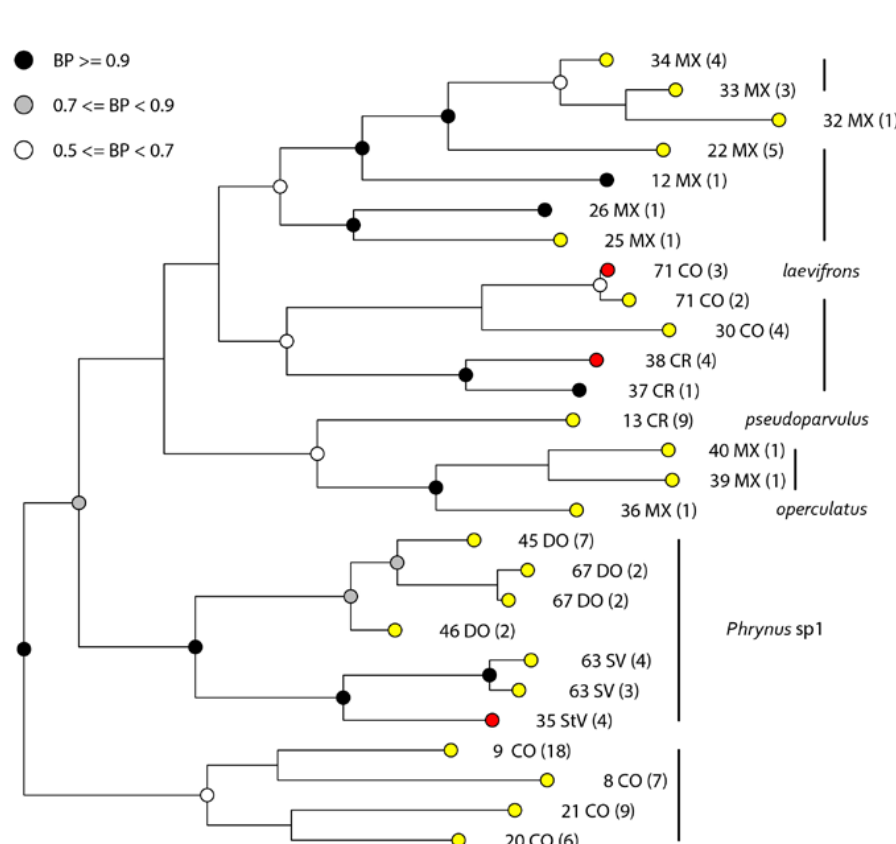
Figure 4. Details of clade C from Figure 3. Colored circles indicate the habitat of each sampled species; yellow = epigean, black = cave, and red = both. Abbreviations refer to area of origin: MX—Mexico, CO—Colombia, CR—Costa Rica, DO—Dominica, StV—St. Vincent. Numbers